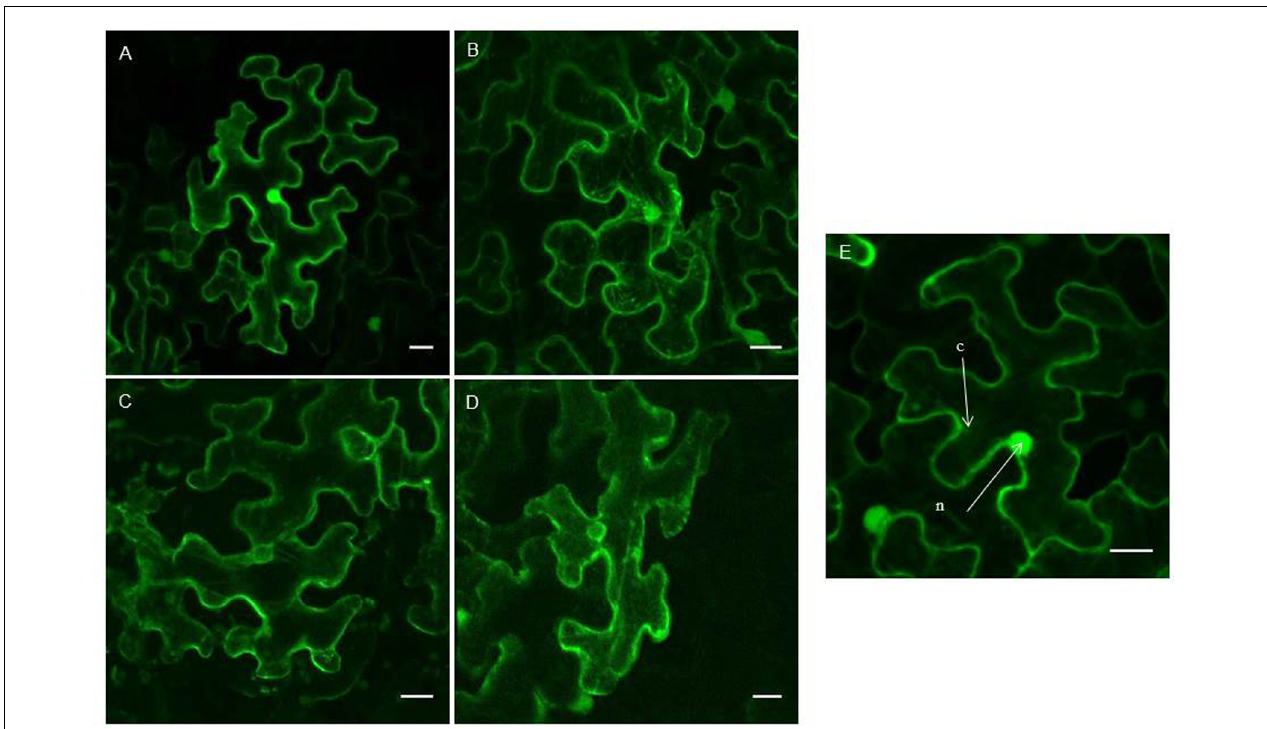
FIGURE 6 | Confocal images of EGFP fusion proteins for different AAT sequences from cucumber. (A–D) Show transiently transformed tobacco leaves with expression of EGFP-AAT4 (A) ; AAT4-EGFP (B) ; EGFP-NAAT1 (C) ; NAAT1-EGFP (D) . (E) Shows a control experiment with free EGFP fluorescence in the cytoplasm and nucleus. Scale bars represent 20 nm. Cell compartments: n, nucleus; c,